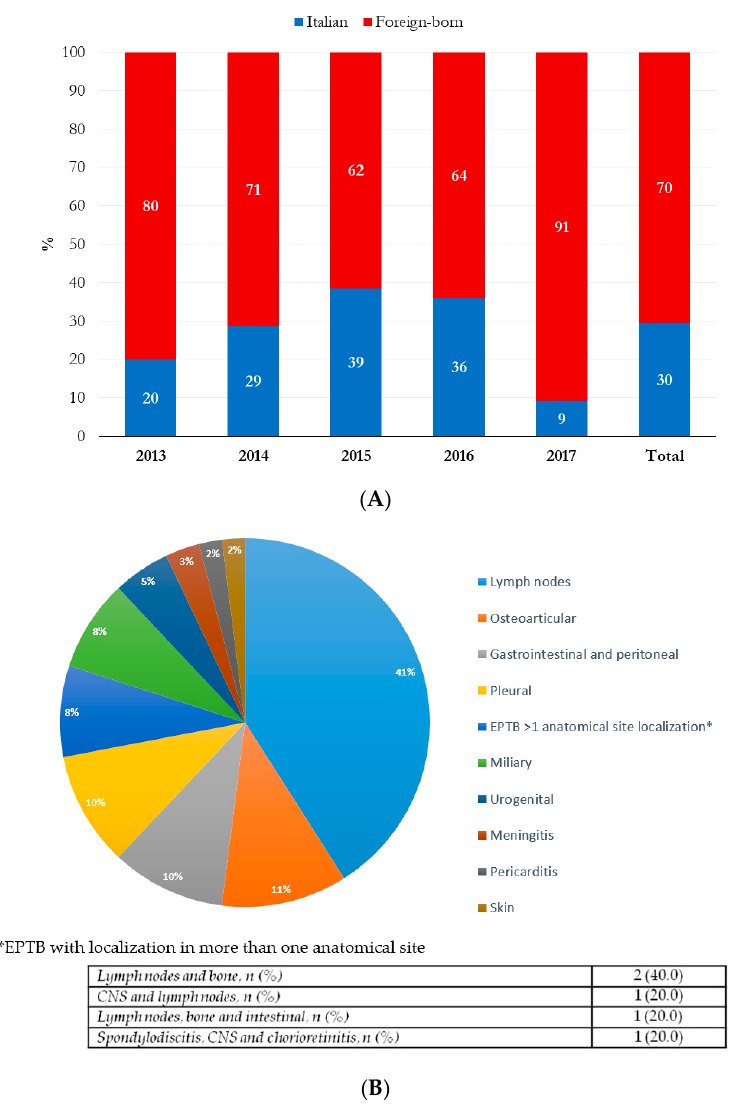
Figure 2. ( A ) Prevalence of EPTB between Italian and foreign-born patients in the study period 2013–2017. ( B ) Anatomical sites of EPTB forms; in the table, EPTB forms with more than one anatomical site of localization are